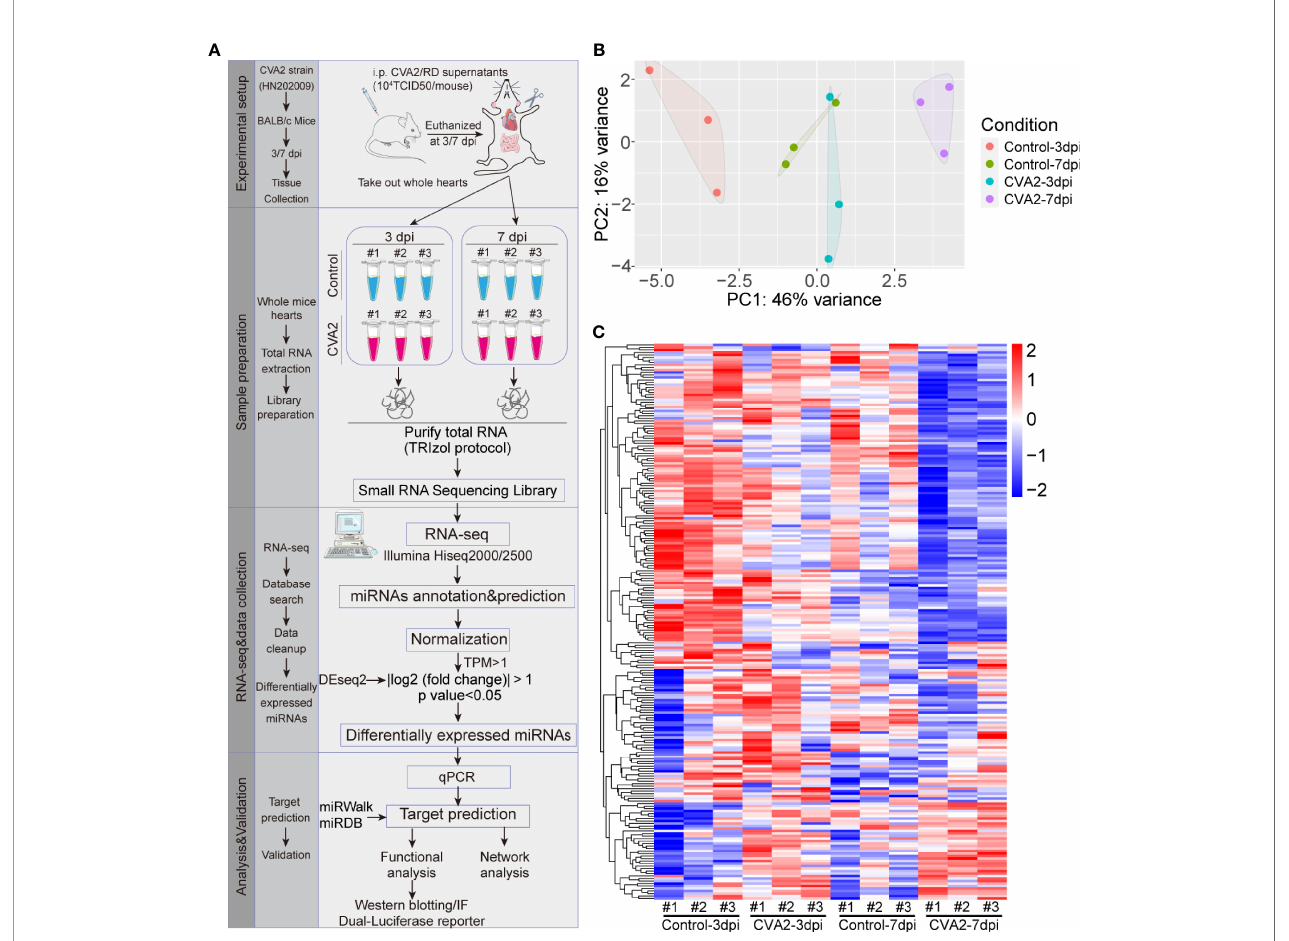
FIGURE 2 | The miRNA expression patterns in heart tissues of CVA2-infected mice. (A) Study design of RNA-seq analysis for CVA2-infected heart tissues. A total of 224 miRNAs with TPM > 1 were detected in heart tissues of CVA2-infected mice at 3 and 7 dpi. (B) Principal component analysis of the miRNA pro fi le. Biological replicates were generated for each sample, represented by different color points in the fi gure. (C) The expression patterns of miRNAs at 3 dpi, and 7